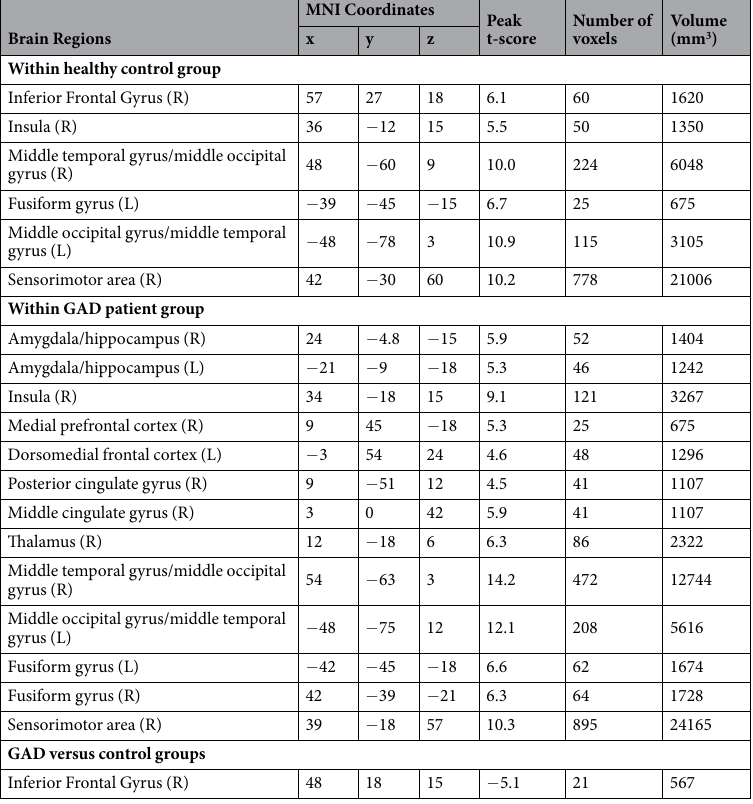
analysis, we found positively functional coupling between the right IFG and bilateral fusiform gyri and right MOG in HCs. In contrast, we observed that the right IFG positively interacted with the left fusiform gyrus, and negatively interacted with the superior frontal gyrus in GAD patients (Fig. 5 and Table 3). Compared with HCs, we found that functional interaction between right IFG and anterior cingulate cortex (ACC) and vmPFC was